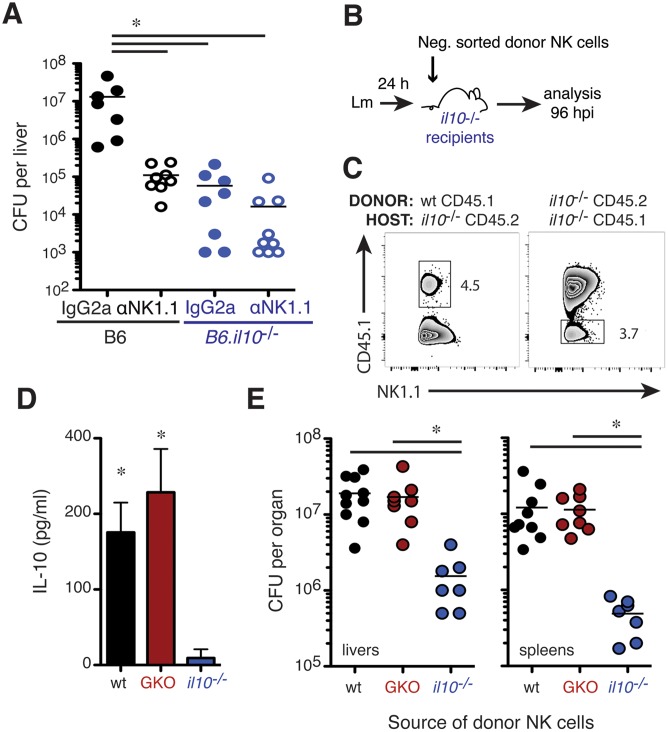
NK cell IL-10 production drives increased Lm burdens.(A) Liver CFU from individual B6 and congenic IL-10 deficient B6 (B6.il10
-/-) mice at 72 hpi. IgG2a or αNK1.1 Abs were given 24 h before infection. Pooled from two experiments representing n = 7–9 mice/group. (B) Design of cell transfer experiments. NK cells were purified from naïve wt CD45.1+ (B6.ptprc
a), IL-10-deficient CD45.2+ (B6.il-10
-/-), or IFNγ-deficient (GKO) CD45.2+ mice for transfer into infected B6.il-10
-/- recipients. (C) Detection of CD45.1+ donor NK cells in B6.il10
-/- recipients at 96 hpi. Live gated CD3-NK1.1+ splenic NK cells are shown. (D) IL-10 from splenic lysates of infected B6.il-10
-/- recipients 72 h after NK cell transfers. Shown are mean ± SEM for one of three experiments using n = 3–4 mice/group. (E) Lm burdens from indicated tissues of B6.il-10
-/- recipients 96 hpi. *P< 0.05 as determined by (A) ANOVA or (D, E) t-test.